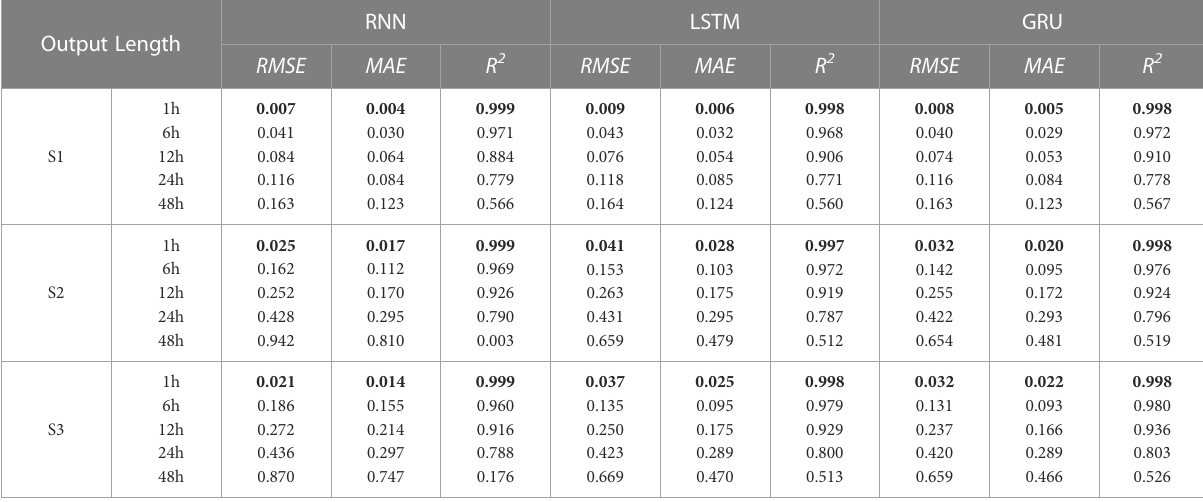
TABLE 3 The prediction result of signi fi cant wave height.